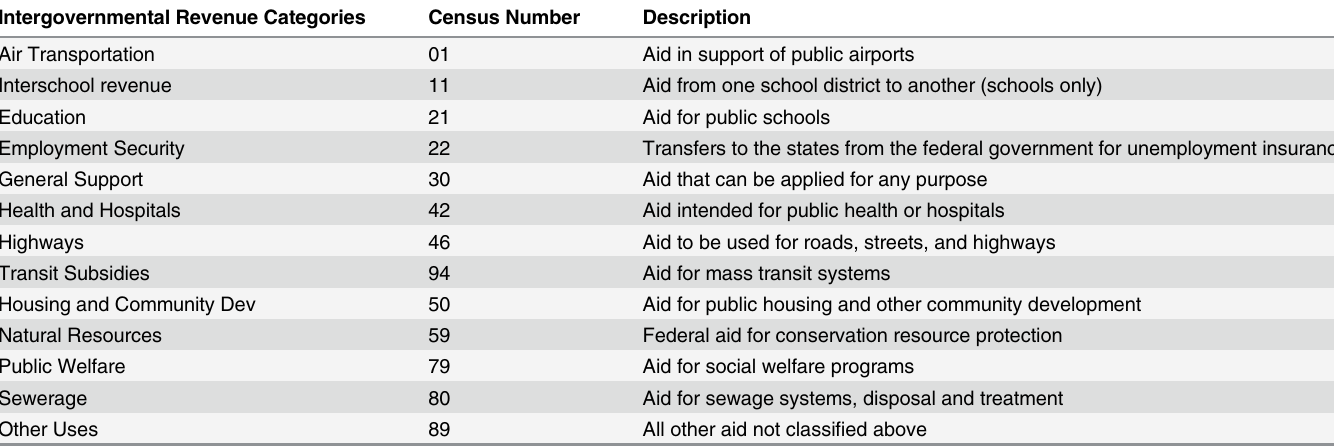
Table 3. Intergovernmental Revenue